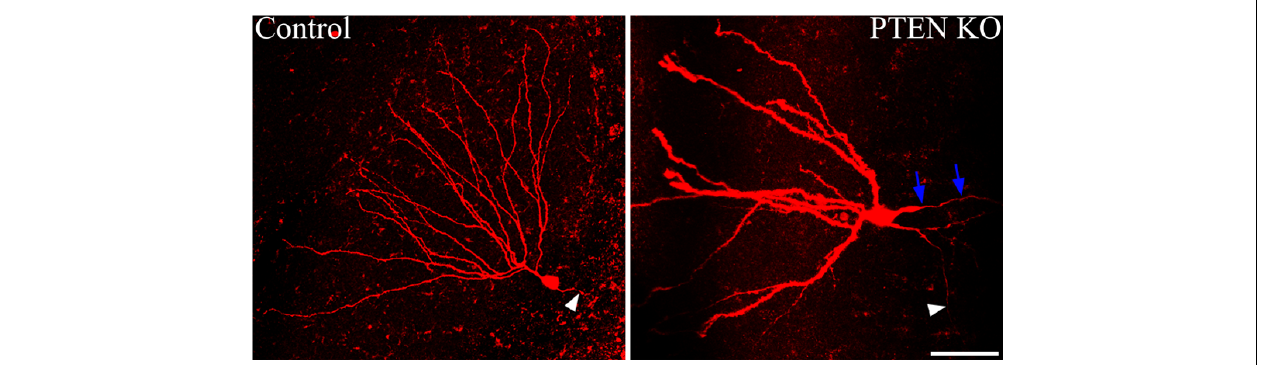
to the control dentate granule cell. Additionally, basal dendrites are commonly found on the PTEN-negative cells, here indicated by blue arrows.White arrowheads highlight the mossy fiber axon extending toward the hilus from each of the two cells. Scale bar = 50 μ m. Images courtesy ofVictor R. Santos and Dr. RaymundY. K.